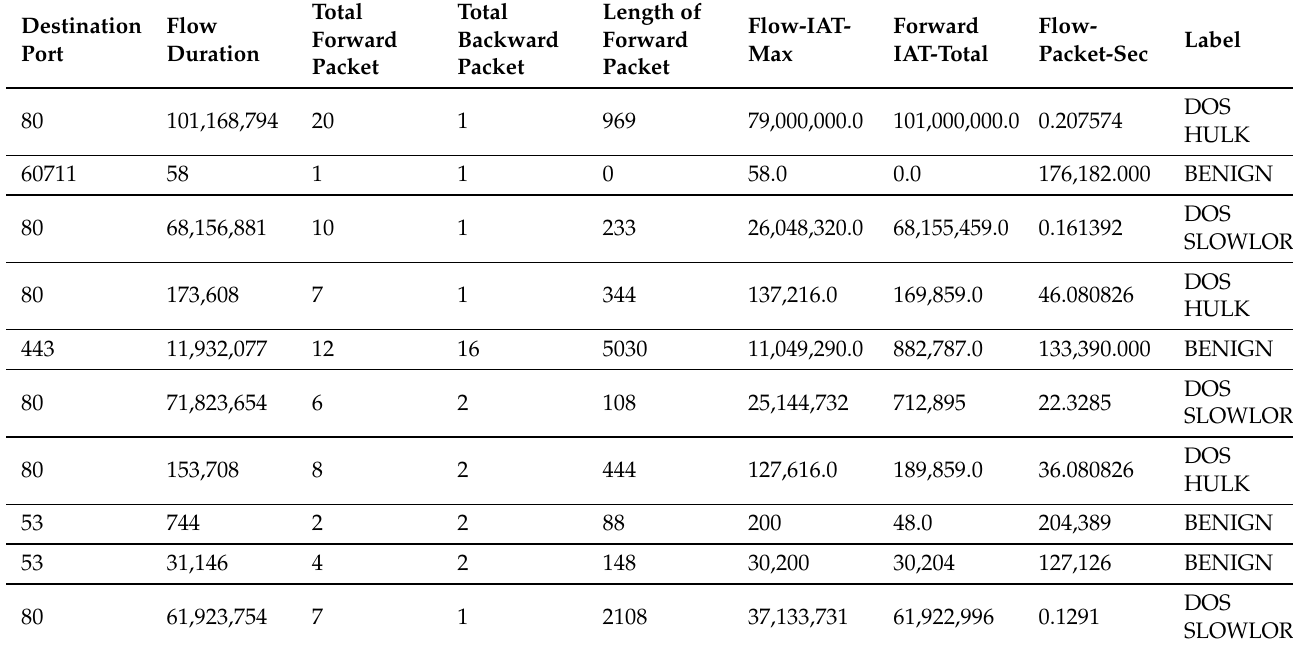
Table 4. Sample from